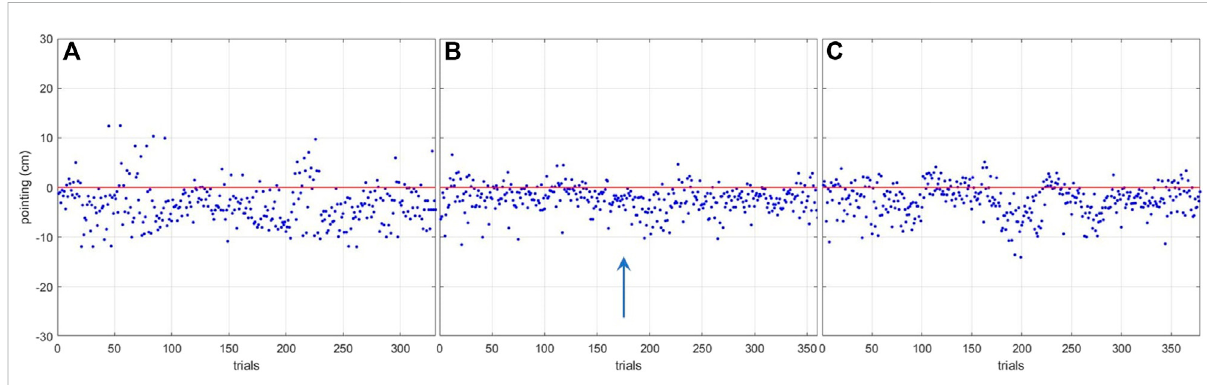
FIGURE 8 Global pointing performances in the three conditions. (A) real-world condition. (B) corresponding virtual reality condition. (C) outdoor virtual reality condition. The red line marks the lower extremity of the target. The blue arrow indicates the direction of the locomotor